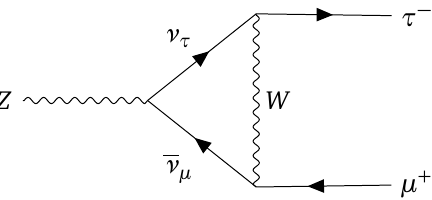
Figure 1: Feynman diagram for the LFV Z → µτ process in the SM beyond the tree level with neutrino